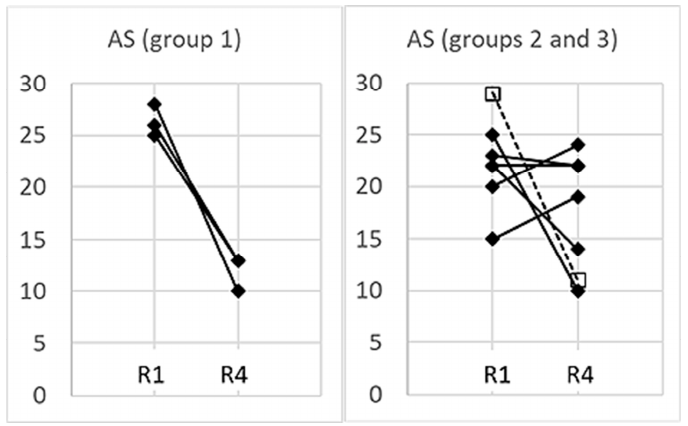
Figure 8. AS values obtained from all 10 subjects in sessions R1 and R4. In the interest of greater clarity, the subjects of group 1 are presented in the left panel and the subjects of groups 2 and 3 in the right panel. Subject #6 (group 3) is marked as - - - .